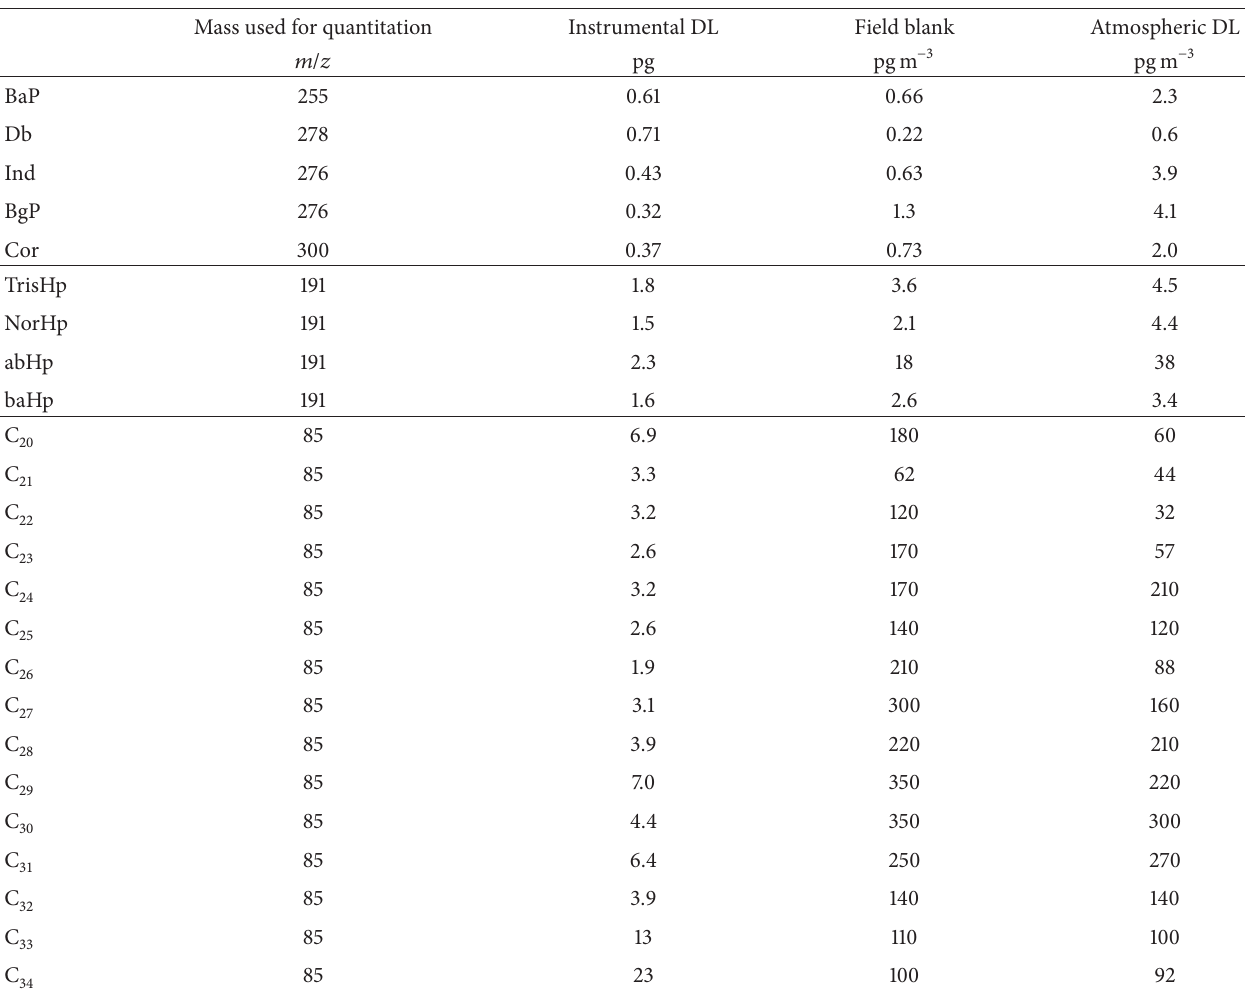
Table 2: List of detection limit (DL) and field